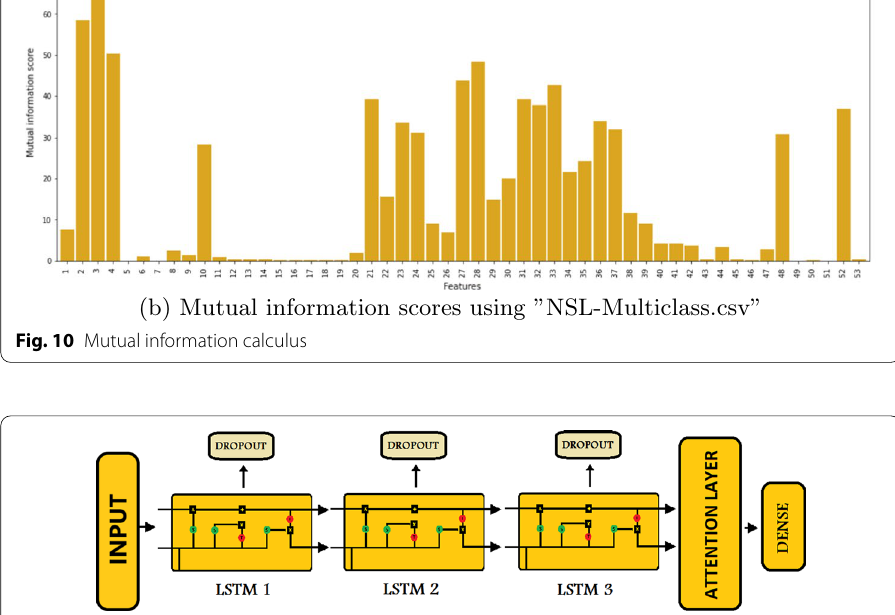
function for multiclass classification. In addition, the proposed Lstm-Attention model is presented in Fig. 11.